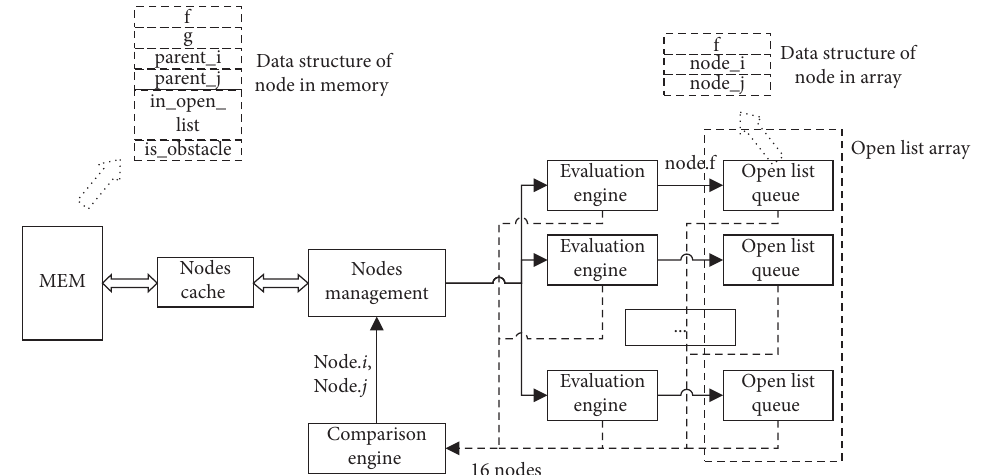
Figure 3: Accelerator’s framework for A ∗ algorithm.